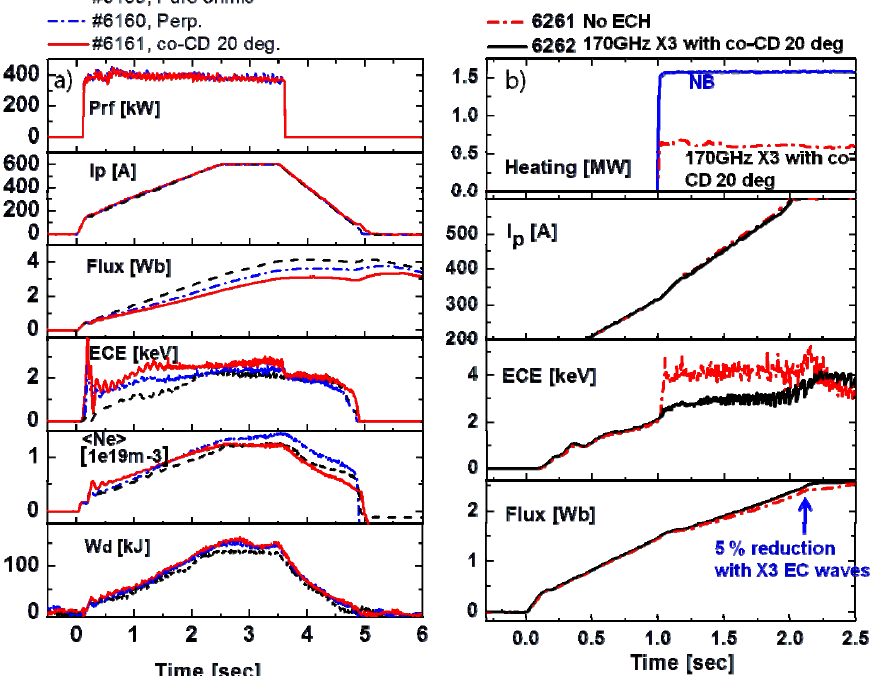
Fig. 4 . ECH injection angle dependence of the 0.4 MW ECH X-mode for the second-harmonic (a) and third- harmonic (b)